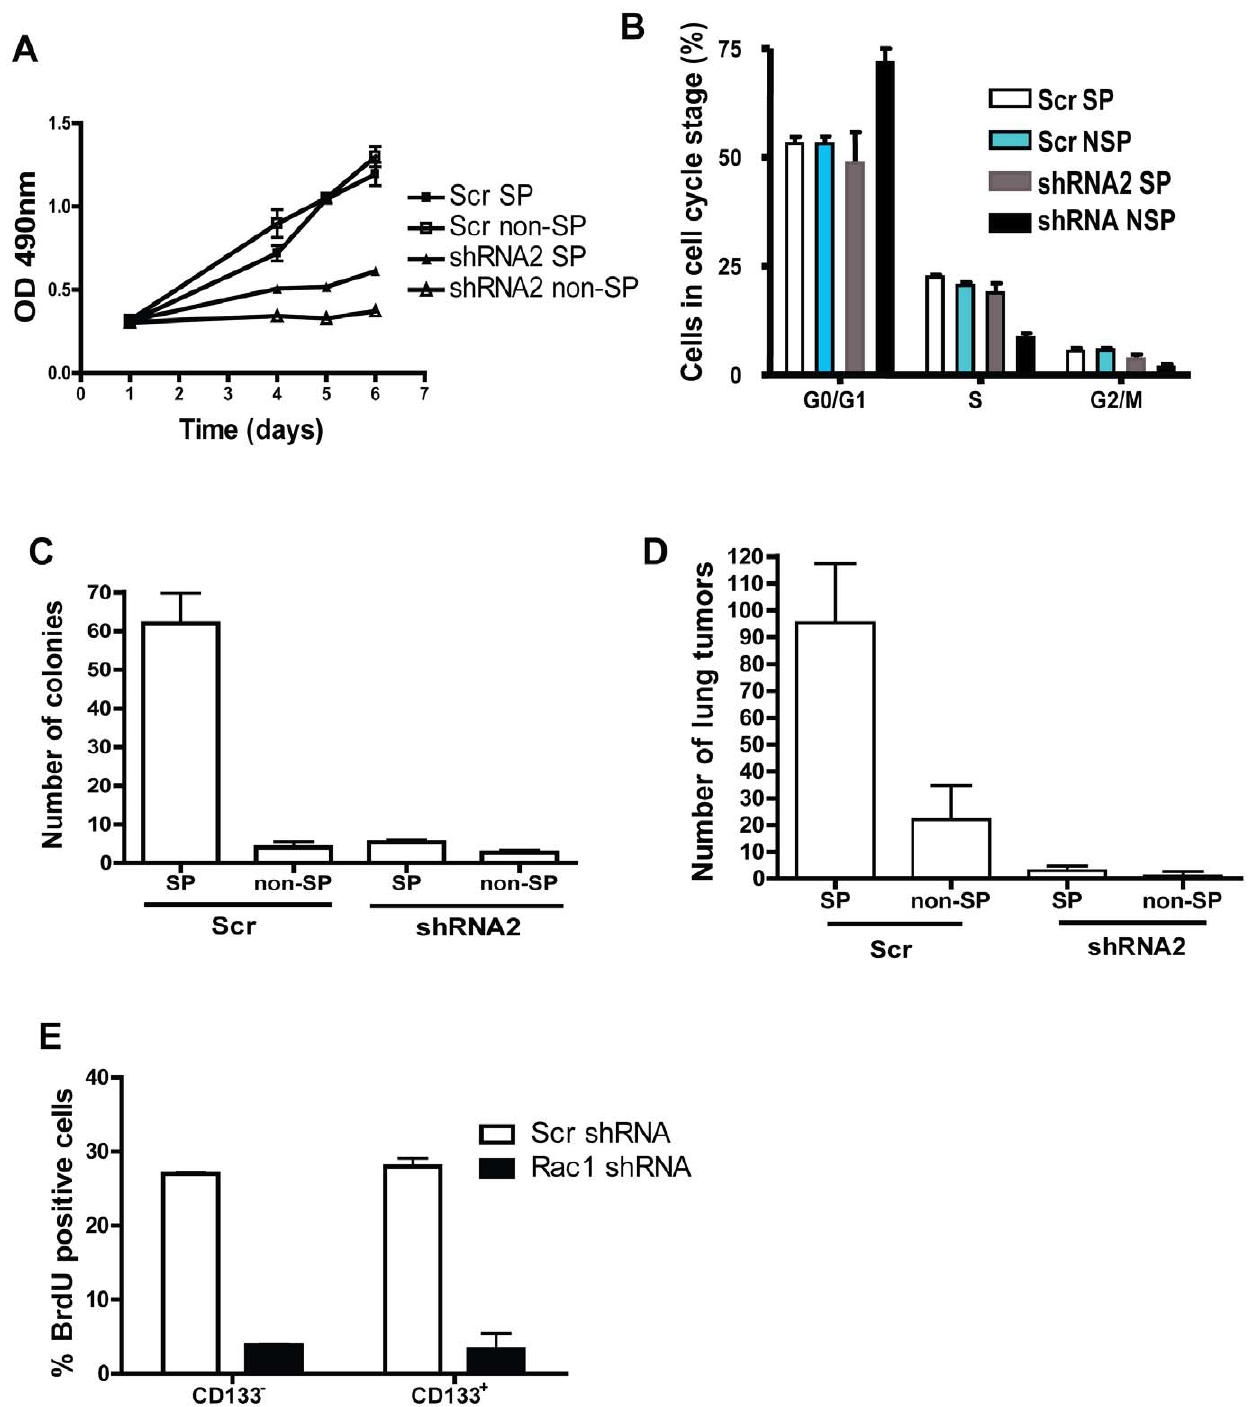
Figure 6. Rac1 knockdown inhibits the proliferation and tumor seeding activities of SP cells as well as non-SP cells invitro and in vivo . (A) Sorted cells were plated in 96-well plate and proliferation assay was performed using MTS reagent. Assay was performed in triplicates and error bars represents SD. Depicted is a representative of three independent experiments. (B) A549 sorted cells were incubated with BrdU and cell cycle analysis was performed by BrdU staining and flowcytometric analysis. Assay was performed in triplicates and error bars represent SD. Above is a representative of two independent experiments. (C) Sorted cell were directly plated for soft agar colony formation assay and the number of colonies formed were counted after 2–3 weeks. Assay was performed in triplicates and error bars represent SD. Above is a representative of three independent experiments. (D) 50,000 sorted cells were injected into tail vein of NSG mice and the lungs were isolated for analysis after 12 weeks. Number of lung tumors was counted under light microscope and error bar represents SE. Results are representative of three independent experiments. (E) Cells were infected with either scr or Rac1 shRNA and incubated with BrdU. Cells were stained with CD133 antibody during the BrdU staining described in methods. BrdU positive cells gated from CD133 + and CD133 2 cells were analyzed by FACS.